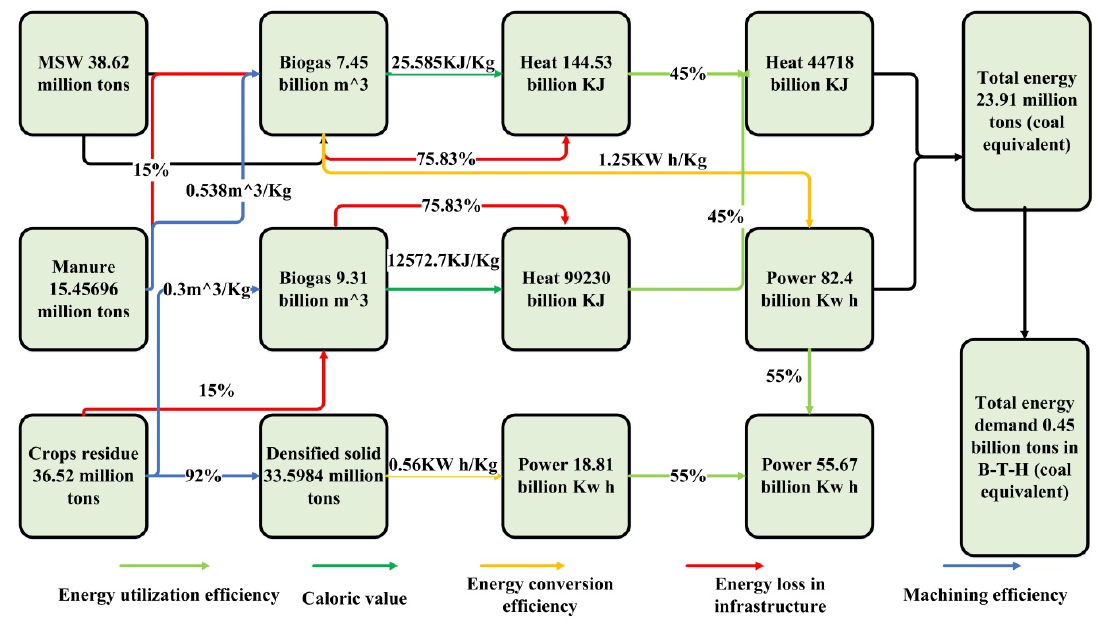
Figure 8. The energy grid of three biomass energy with energy demand total in the B-T-H region [67,75–77].